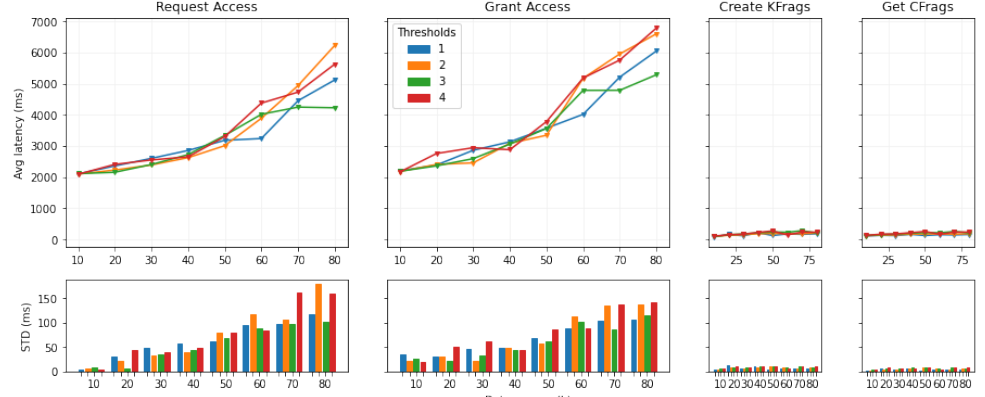
Figure 10. Average response latency and standard deviation for each operation in a round, varying the threshold from 1 to 4 and data owners from 10 to 80.